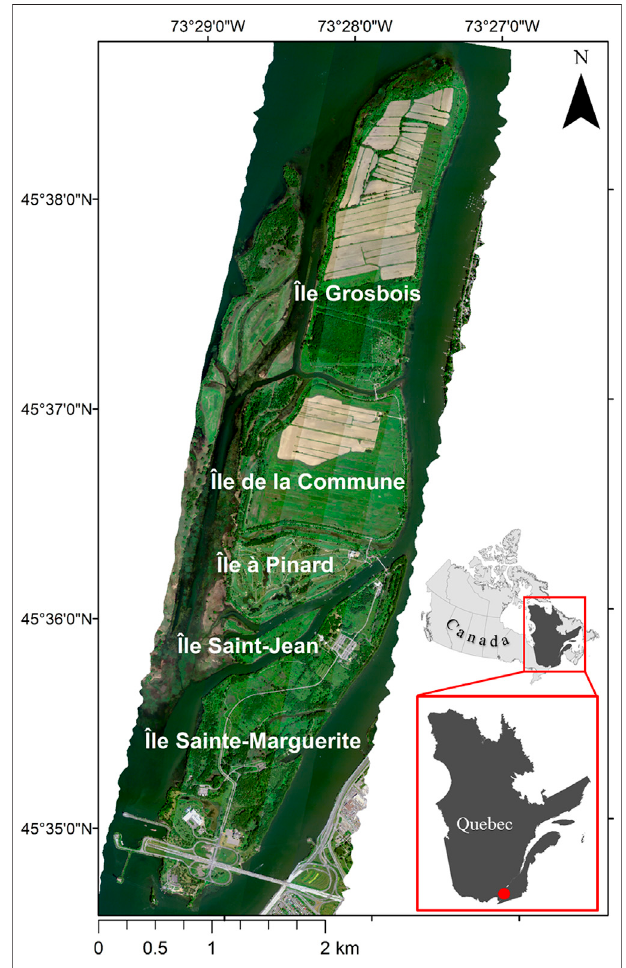
FIGURE 1 | The extent of Îles-de-Boucherville National Park, which consists of fi ve main islands in the Saint Lawrence River. Basemap imagery is the mosaic of the fi ve CASI-1500 fl ight lines acquired on July 08, 2019, displayed using RGB bands 648, 550, and 430 nm. Projection: WAGS84/UTM Zone 18N (EPSG: 32618). The subset in the bottom right corner shows the position of the park (red circle) within the province of Quebec,